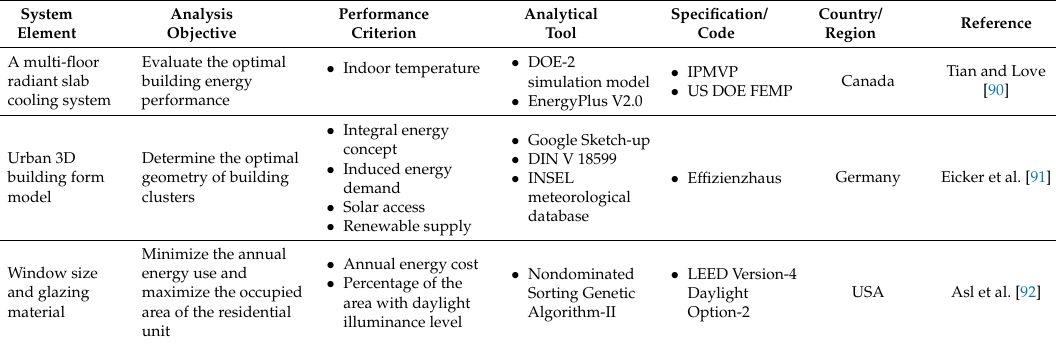
Table A7. Characteristics of urban energy design